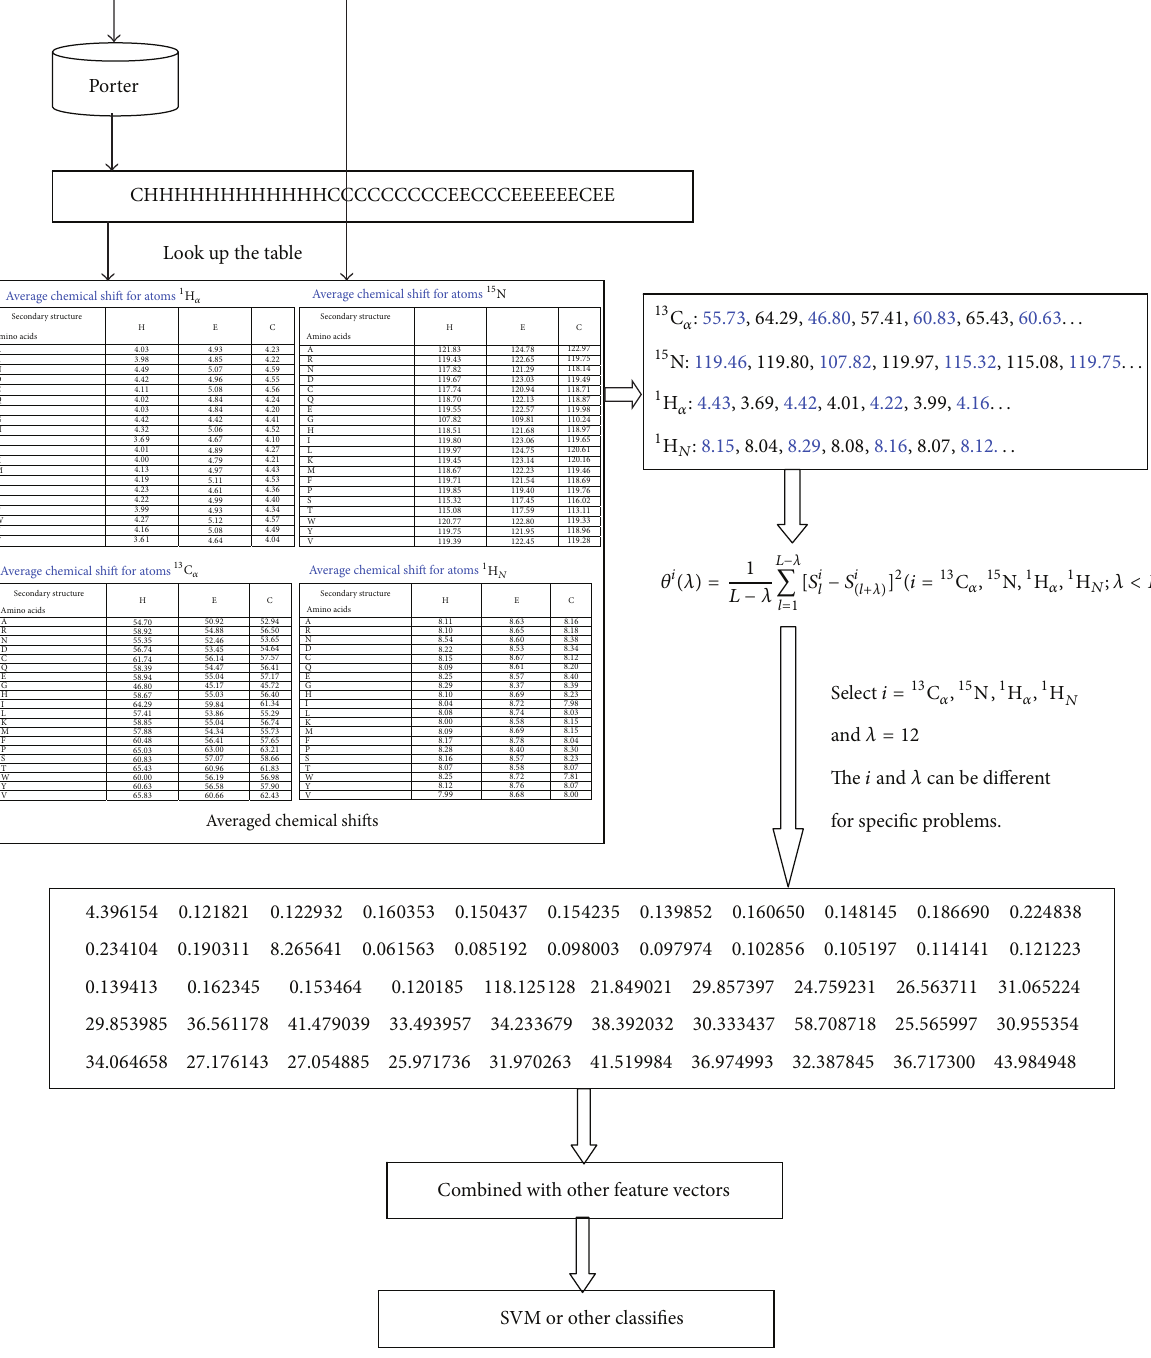
tableMIGLSTYRNLPTLLTTTTVISTALRSKQLLRFTTTTSTK